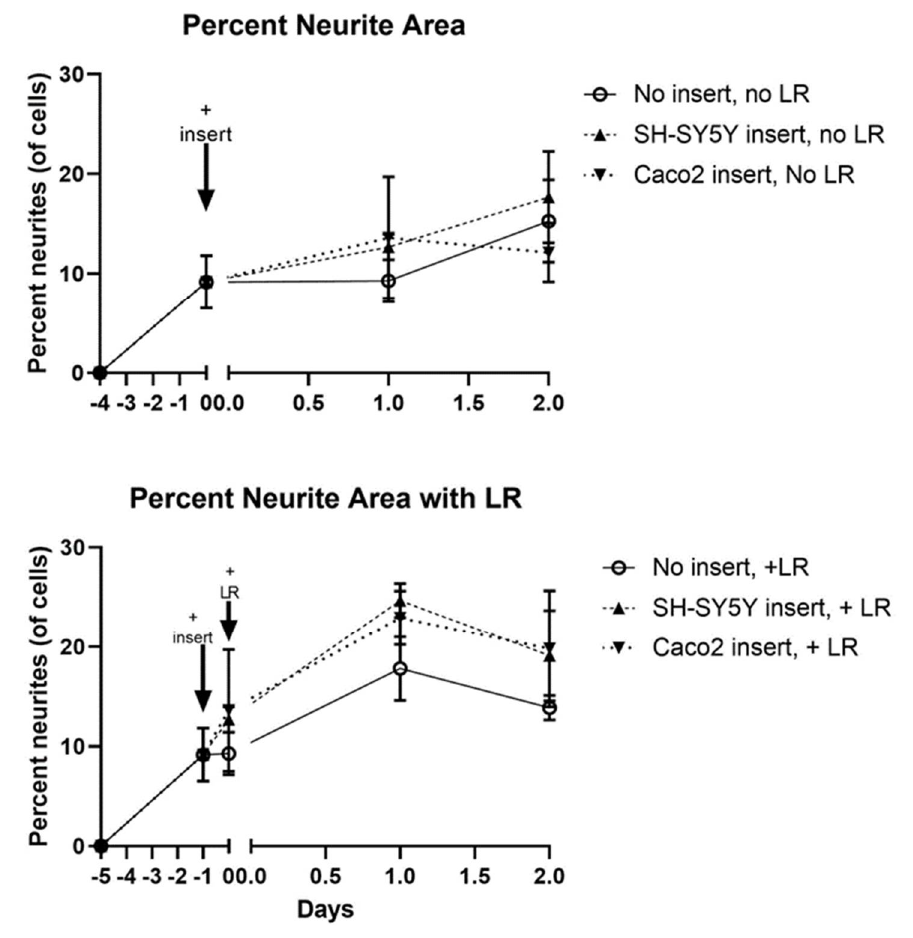
Figure 10. Time course transmembrane effects of Lactobacillius rhamsosus (LR) on SH-SY5Y neurites. Inserts were set up according to the plating and feeding sequence (Figure S4), whether using normal Caco2Bbe1 cells ( n = 25,000) or control SH-SY5Y cells ( n = 25,000 inserts). After 9 days (designated “minus 5 days” on the lower graph), companion SH-SY5Y wells were plated ( n = 50/ well) into open wells of a separate 24-well plate with complete (10% FBS) media. Three days later, the apical media of all inserts was changed to 1% FBS. The next day (day -1 on the lower graph), the first 40 × microscopic photographs were taken of the SH-SY5Y cells, following which the inserts were added to create the 3-dimensional (3D) co-cultures. It should be noted that this experiment intentionally used neuroblastoma cells with medium-length neurites because had SH-SY5Y’s been converted to their full-length neurite phenotype before adding LR, it would have been impossible to observe a rise in neurite length as seen in the lower panel. Upper panel: Transmembrane control of apical 1% FBS on basal neurites. The data follow the percent of neurites per total cell volume according to type of inserts with apical 1% FBS in the media, either in: 13-day-old blank inserts, 13-day-old SH-SY5Y inserts, or 13-day-old Caco2Bbe1 inserts. Lower panel: LR transmembrane effect on basal neurites. Fifteen hours after the model became 3D (still running in parallel with upper panel), LR was applied apically ( n = 1.0 × 10 7 ) to all inserts. The time course followed the percent of neurites per total cell volume according to type of inserts, starting as either: LR on 13.6-day-old blank inserts, LR on 13.6-day-old SH-SY5Y inserts, or LR on 13.6-day-old Caco2Bbe1 inserts. Plots are means ± SEMs. of tight junctions (not so with blank or SH-SY5Y inserts that failed at any time to register TEER; data not shown here but fully expected since SH-SY5Y cells do not form tight